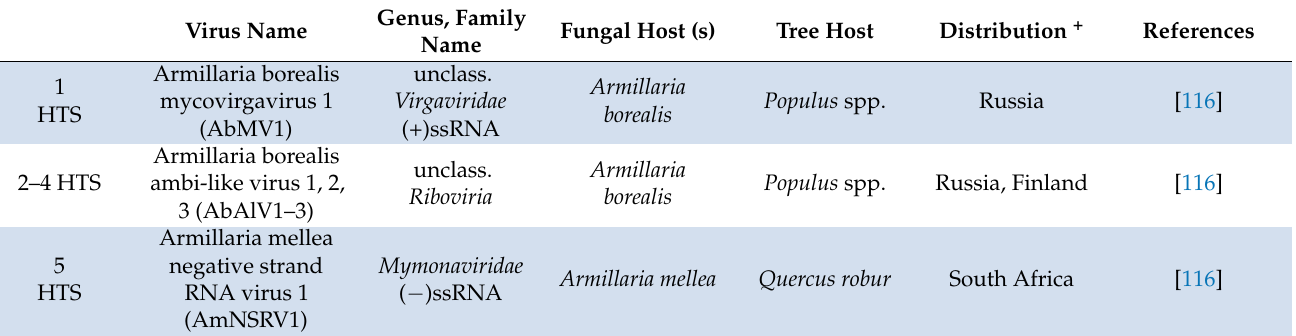
Table 2. Mycoviruses occurring in plant pathogenic fungi. For each virus, the virus name, genus and family name, fungal host(s), tree species, countries in which the virus was reported and the related references are given. Numbers in the first column represent ordinal numbers of the listed viruses. Viruses that were discovered by means of HTS methods are indicated by the note “HTS” next to their ordinal